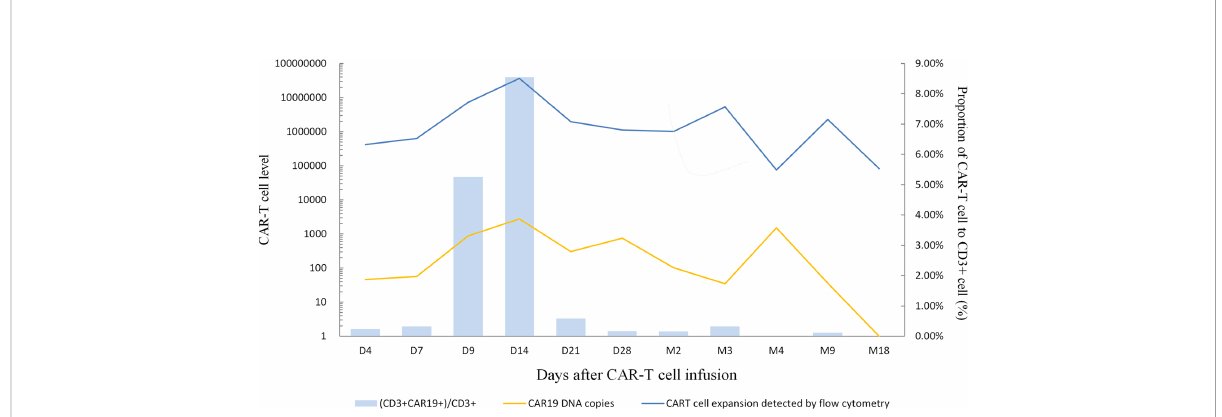
FIGURE 3 CAR19 DNA copies, CART cell expansion levels detected by fl ow cytometry and the proportion of CAR-T cell to CD3+ cell during treatment. The peak levels appeared on day 14 after CAR-T cell infusion, indicating CAR19 DNA copies were 2.79×103 copies/ m g, CAR-T cells expansion detected by fl ow cytometry was 3.64×107/L and CD3+CAR19+/CD3+ T-cell was